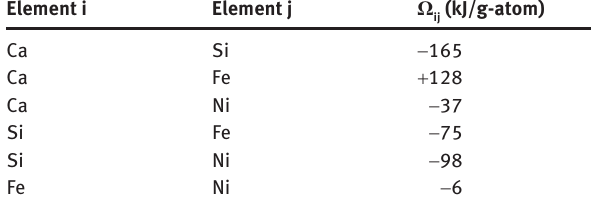
Table 3: Interaction parameters W ij between elements